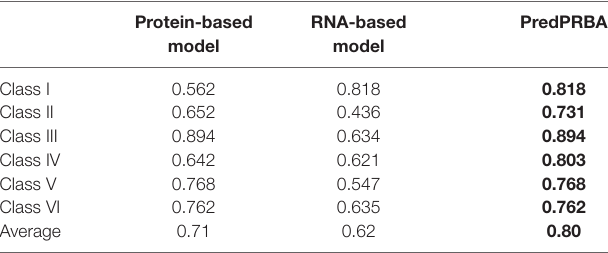
TABLE 4 | Performance comparison of PredPRBA to protein-based and RNA- based prediction models. Protein-based model